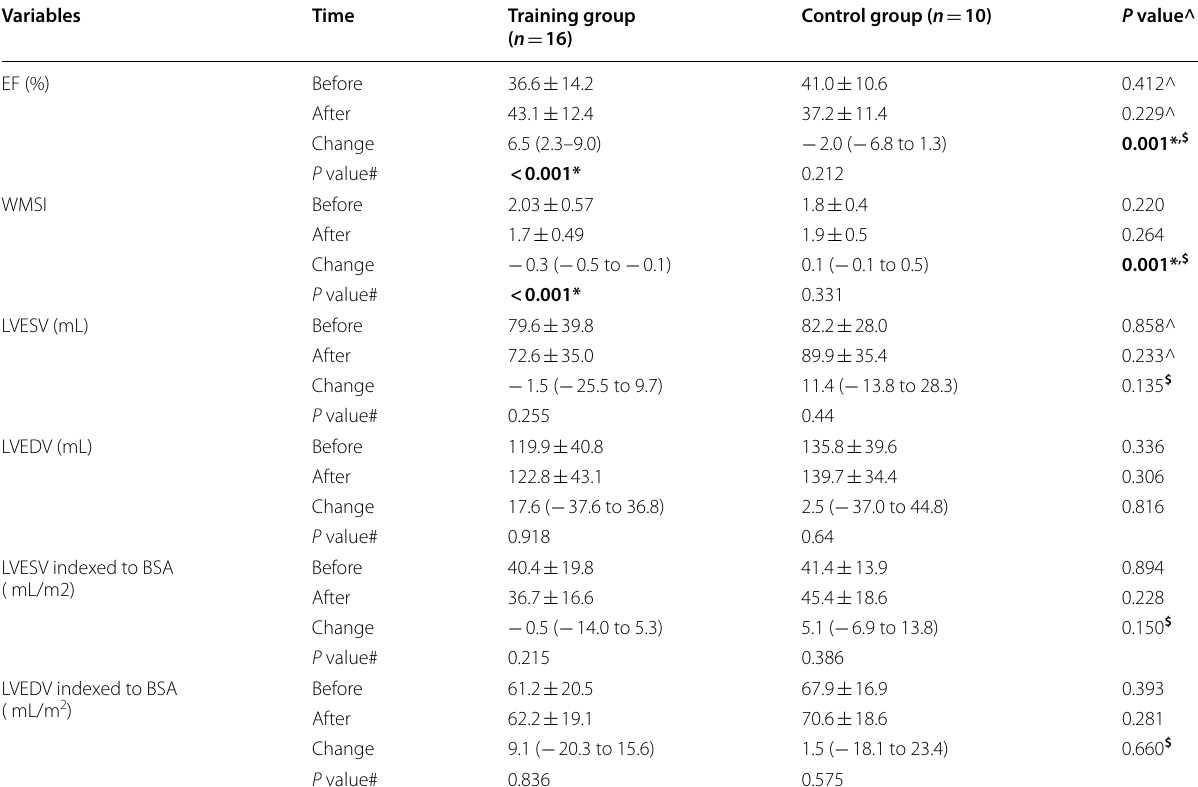
Table 4 CMR parameters (EF, WMSI, LVESV, LVEDV, and LV volumes indexed to BSA) before and after the study